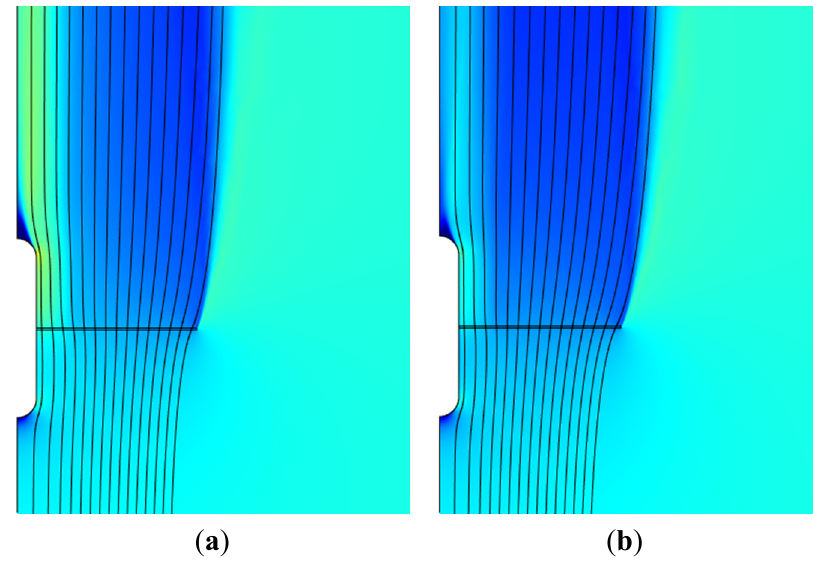
Figure 16. Axial velocity and streamlines. (cid:1829) Nacelle/rotor: Centerbody with cylindrical root